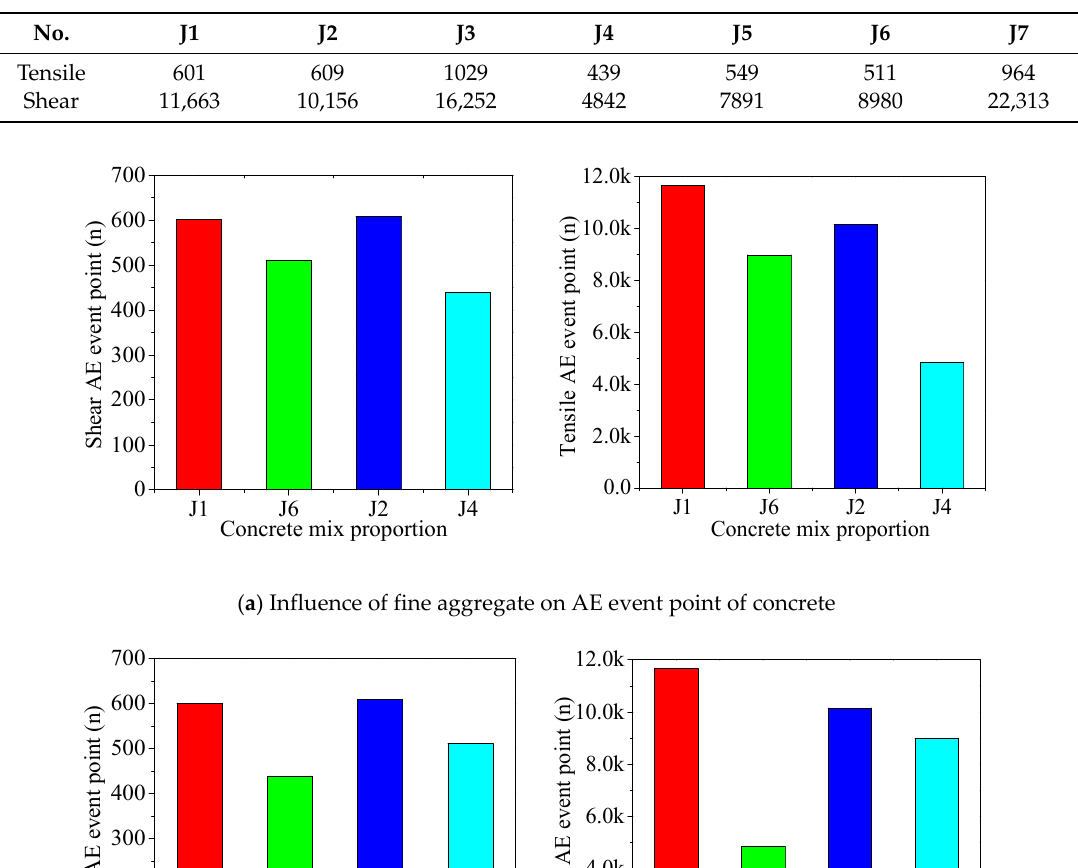
Table 7. Statistics of concrete AE event points.